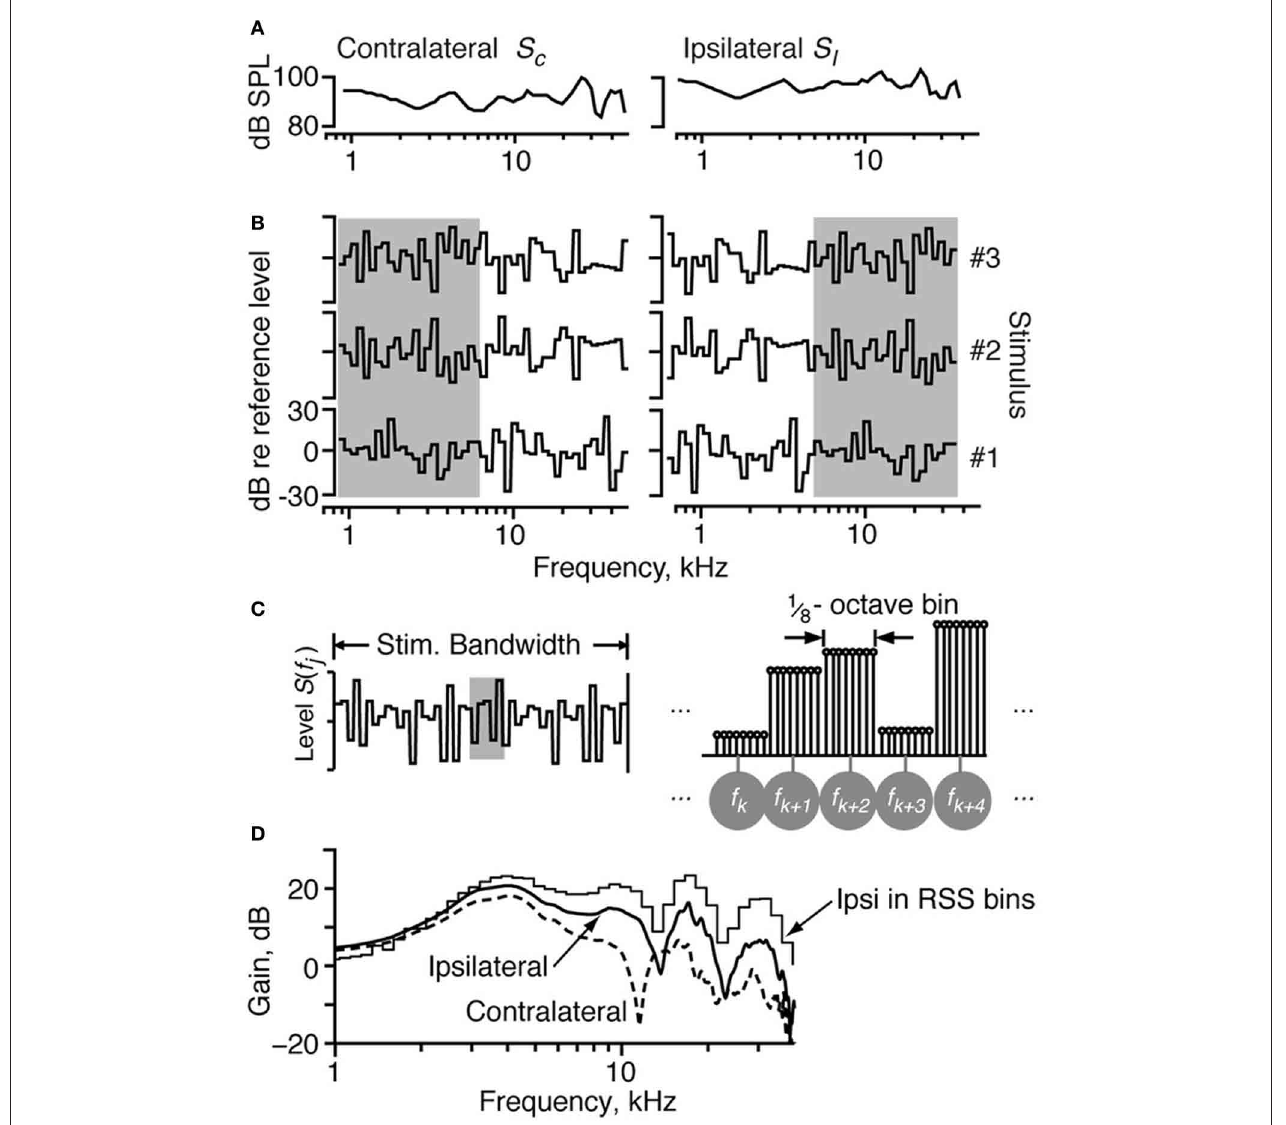
FIGURE 1 | The properties of the RSS stimuli. (A) The acoustic calibration of the two ears in one animal, showing the sound pressure level as a function of frequency at 0dB attenuation. These were determined using a calibrated probe tube placed within 2mm of the eardrum. The spectra of sounds were modified by filtering with these transfer functions. (B) Spectra of three example RSS stimuli, out of the set of 200, shown as the dB spectrum level vs. log frequency. The sound levels of individual frequency bins (of width 1/8 octave) are symmetrically distributed around a mean value of 0dB, with SD 12dB. The reference 0-dB sound level is varied with an attenuator, usually over a 50–70dB range. Note that the spectra presented to the ipsilateral ear are frequency-shifted versions of the spectra presented to the contralateral ear